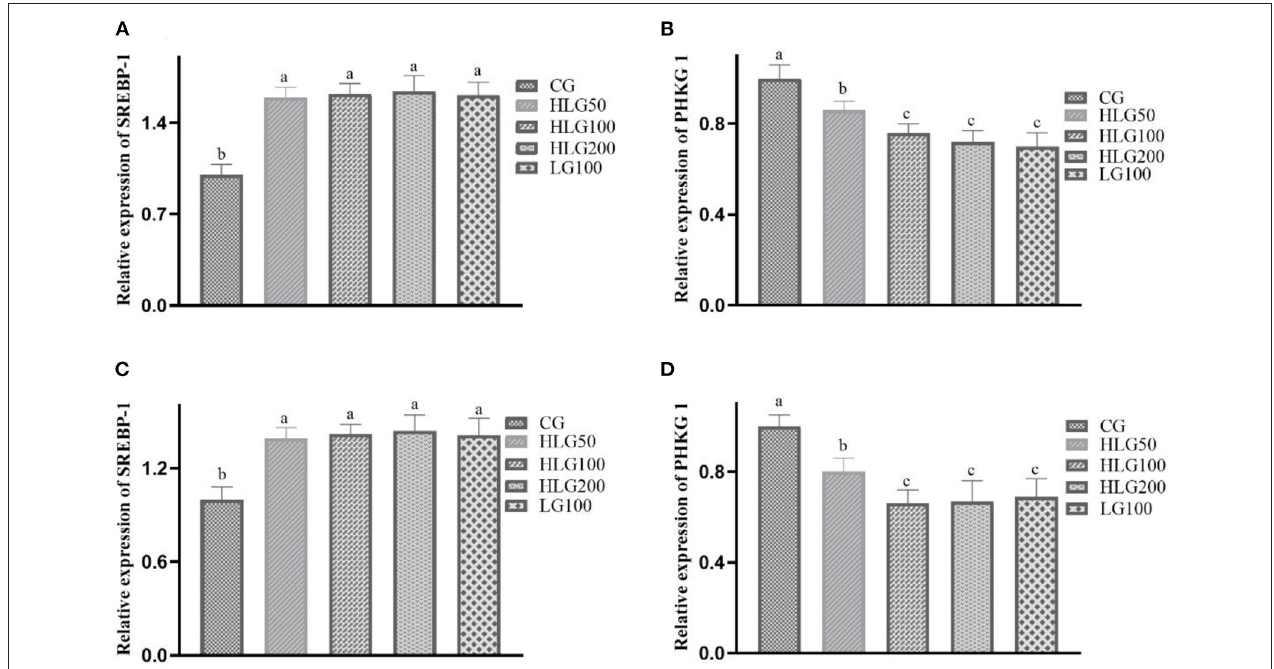
FIGURE 1 | The relative expression levels of genes relative to meat quality in breast and leg muscle of Jiangnan White goslings. The data in CG, HLG50, HLG100, HLG200, and LG100 in breast muscle were (A) SREBP-1 gene: 1.00 ± 0.10 b , 1.59 ± 0.08 a , 1.62 ± 0.08 a , 1.64 ± 0.12 a , 1.61 ± 0.10 a , respectively; (B) PHKG 1 gene: 1.00 ± 0.10 a , 0.86 ± 0.04 b , 0.76 ± 0.04 c , 0.72 ± 0.05 c , 0.70 ± 0.06 c , respectively; The data in CG, HLG50, HLG100, HLG200, and LG100 in leg muscle were (C) SREBP-1 gene: 1.00 ± 0.10 b , 1.39 ± 0.07 a , 1.42 ± 0.06 a , 1.44 ± 0.10 a , 1.41 ± 0.11 a , respectively; (D) PHKG 1 gene: 1.00 ± 0.10 a , 0.80 ± 0.06 b , 0.66